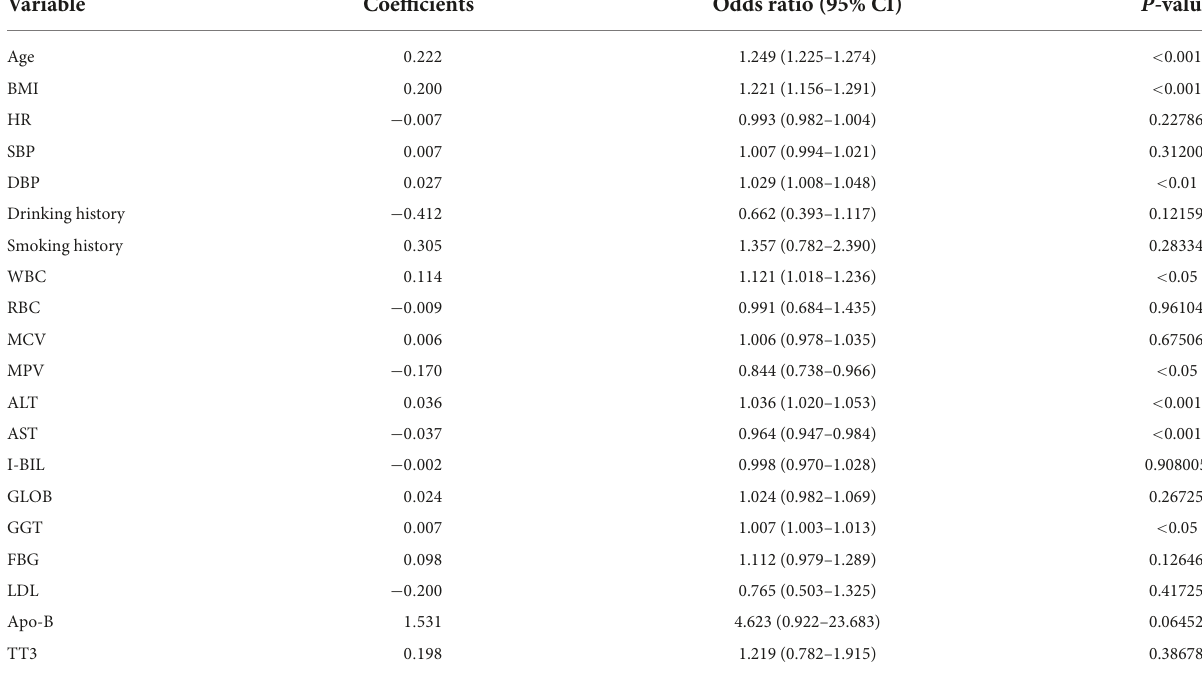
TABLE 3 Multivariate logistic regression analysis.